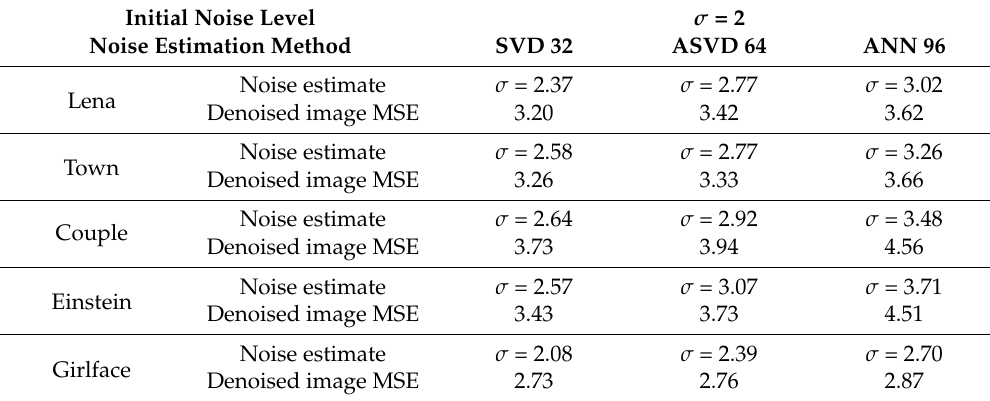
Table 2. The image denoising performance associated with different noise level estimation algorithms.